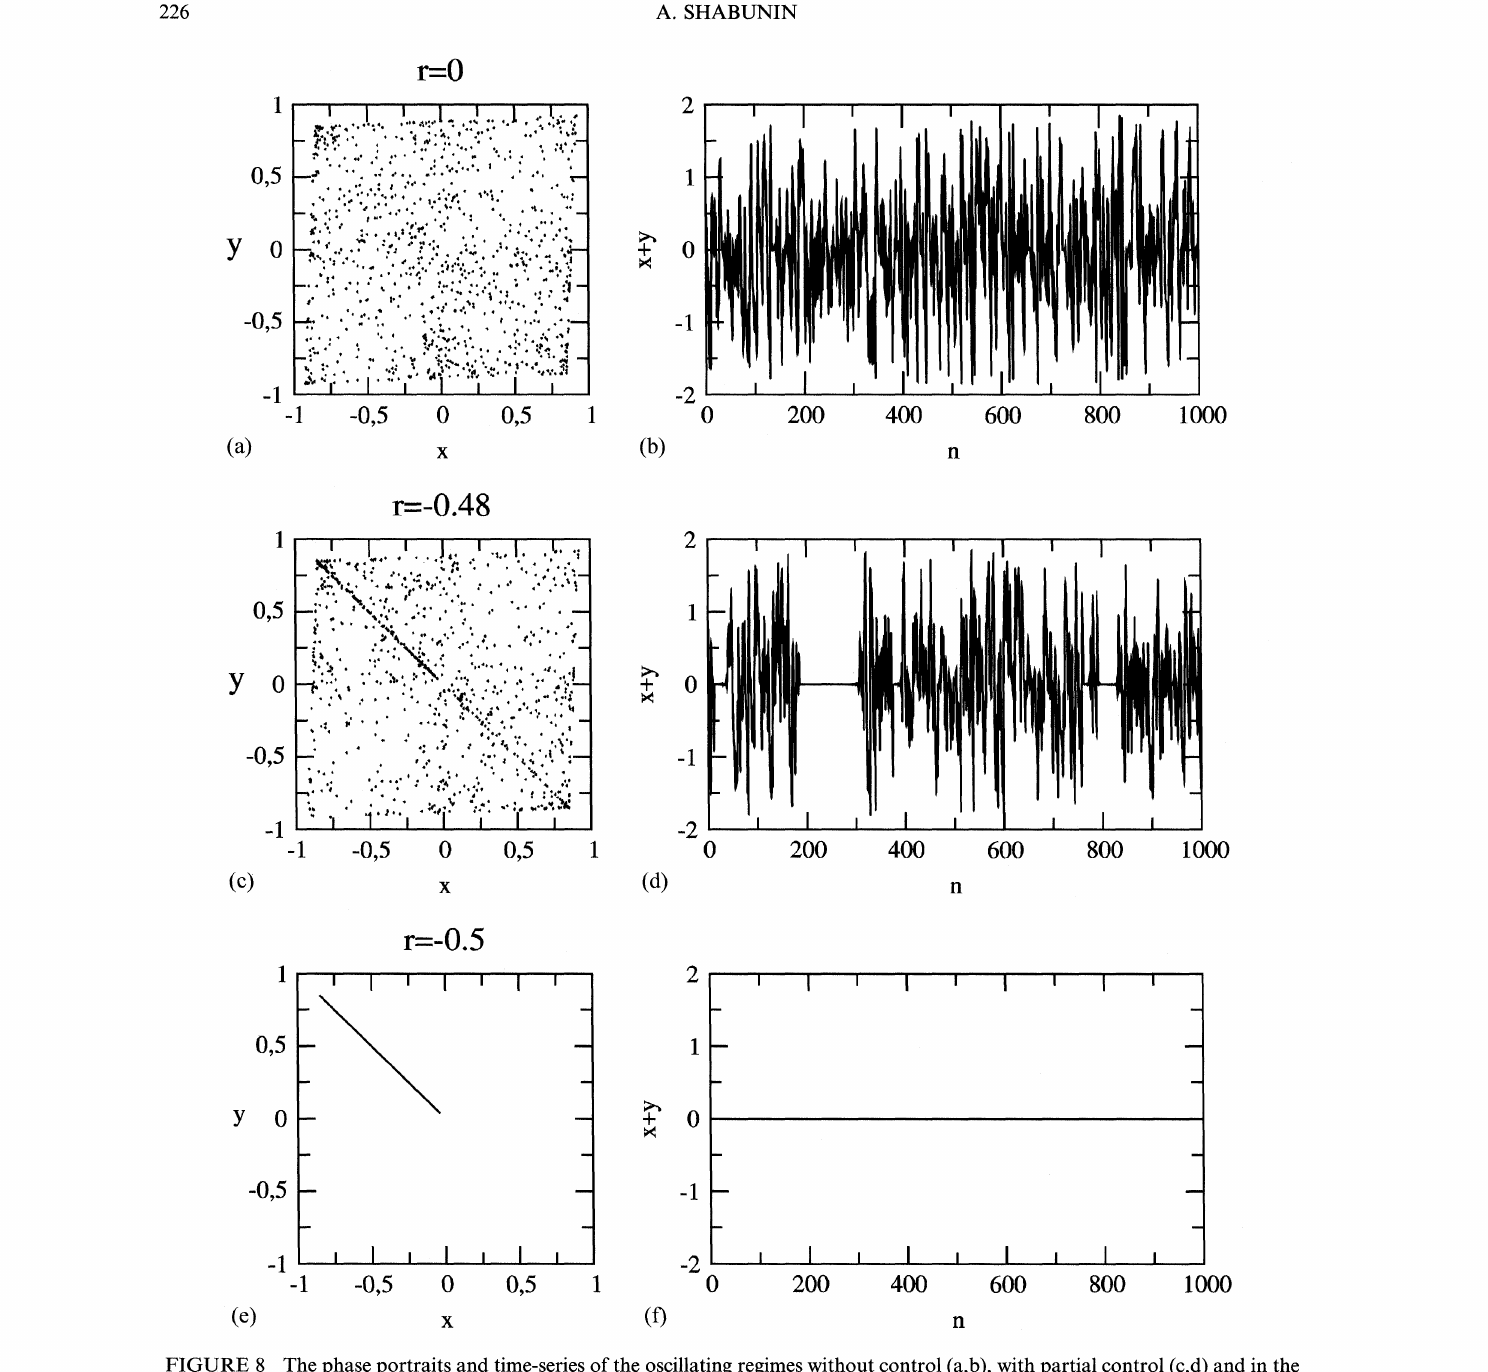
FIGURE 8 The phase portraits and time-series of the oscillating regimes without control (a,b), with partial control (c,d) and in the regime of the complete antiphase synchronization (e,f). depends on the initial values. Adding noise of gets finite transversal size. Phase point begins to small intensity leads to essential rebuilding of the visit neighborhoods of the both fixed points Clo phase portrait of the oscillations. The attractor and C20. The corresponding time-series of xn + yn